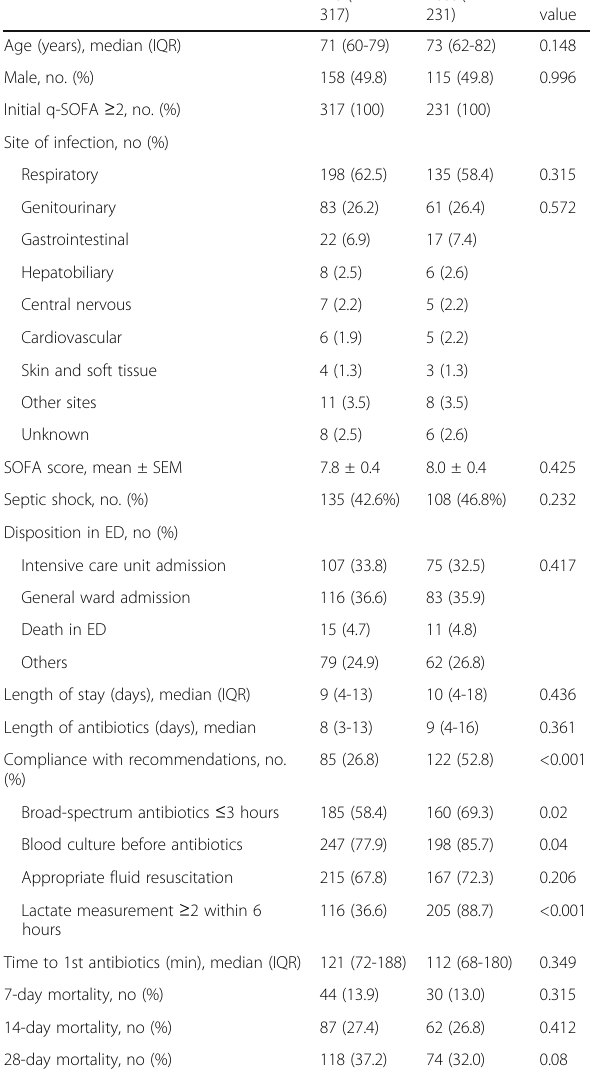
Table 1 (abstract P13). Baseline characteristics of enrolled patients and comparison between preperiod and